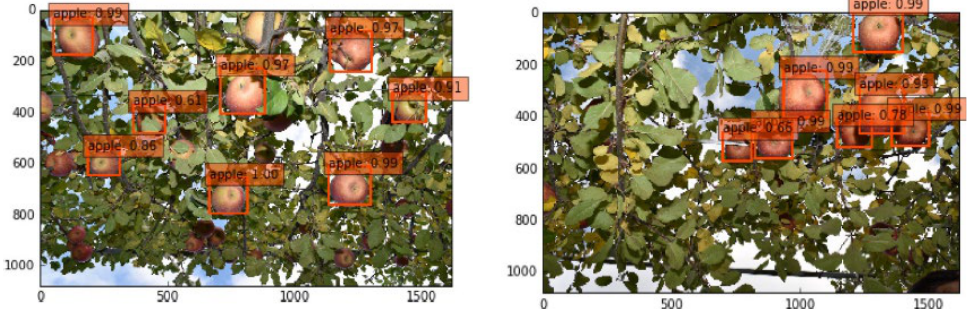
Figure 2. Fruit detection using CNN